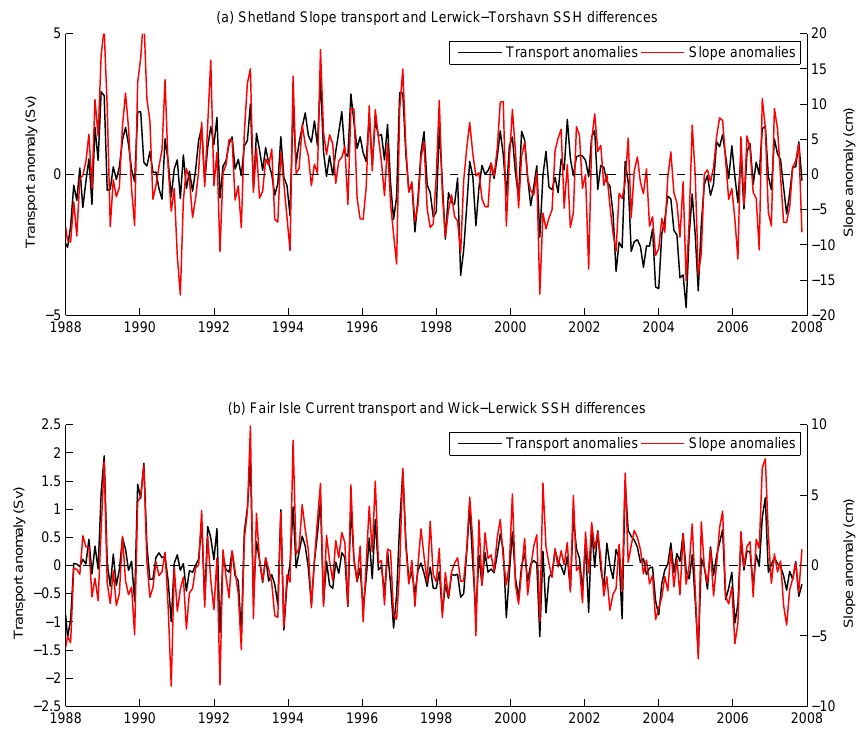
Figure 14. 30-day running averages of anomalies (relative to seasonal cycles over 1988–2007) of (a) Shetland Slope transports and Lerwick– Tórshavn SSH differences, and (b) Fair Isle Current transports and Wick–Lerwick SSH differences.